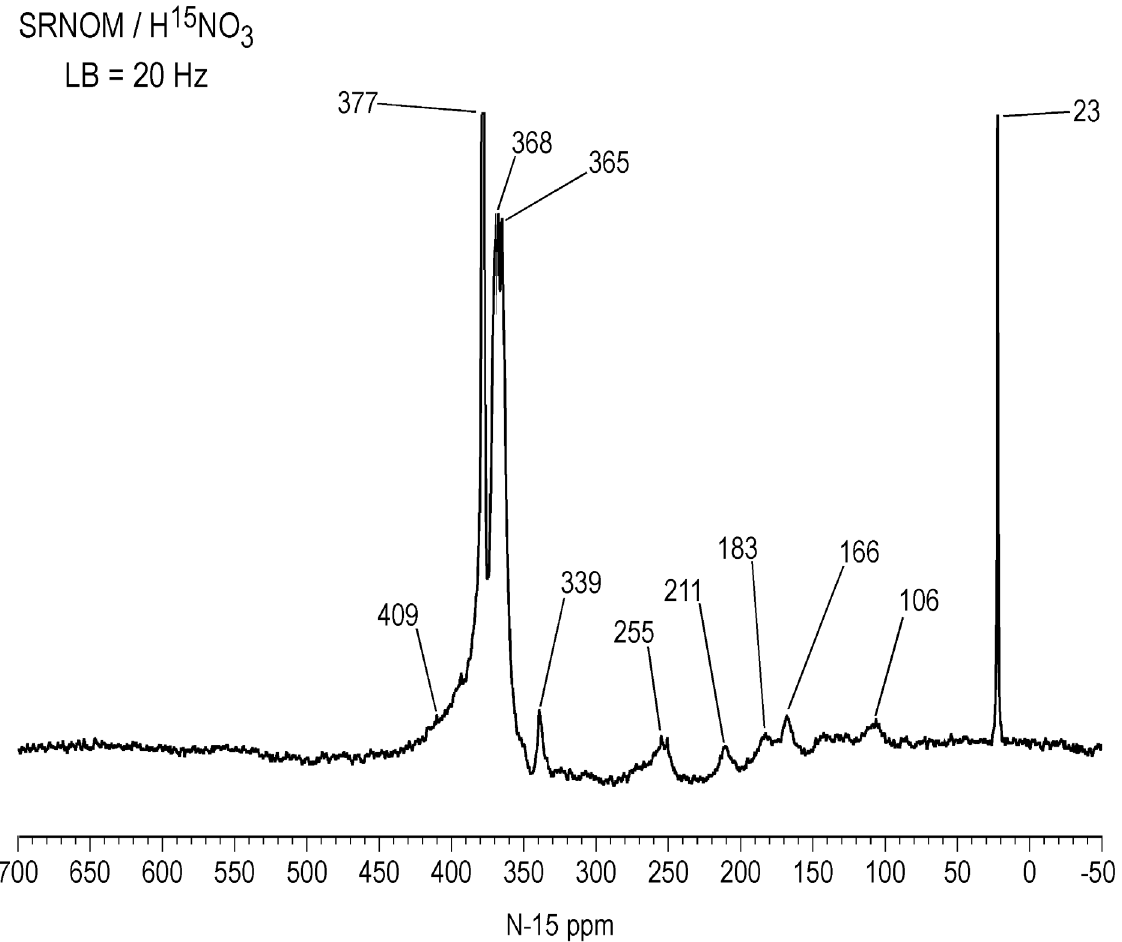
Fig 4. Liquid state inverse gated decoupled N-15 NMR spectrum of Suwannee River NOM treated with N-15 labeled nitric acid. LB = line broadening.